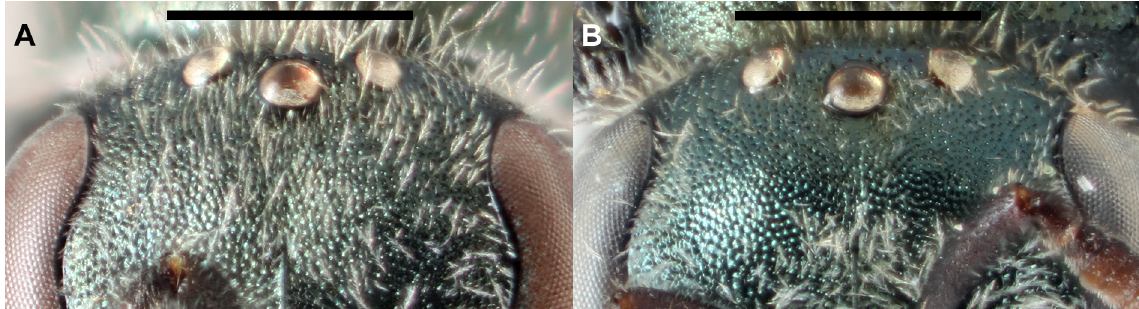
Fig. 96. Frons. A . Lasioglossum holzenthali sp. nov., ♀, roughened and dulled by crowded punctures without distinct interspaces. B . L. lepidii (Graenicher, 1927), ♀, smooth and shiny between punctures. Scale bars = 0.5